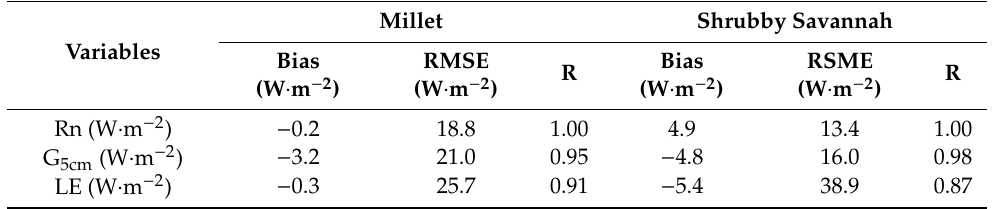
Table 3. Skill scores—bias, root mean square error (RMSE), and correlation coe ffi cient (R)